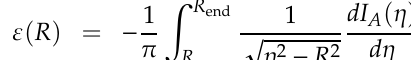
Figure 4. Population coefficients for 𝑝 = 6. The green, red, and blue lines represent 𝑟 (cid:2868)(cid:2874) , 𝑟 (cid:2869)(cid:2874) , and 𝑟 (cid:2870)(cid:2874) , respectively. The solid, dashed, and dash-dotted lines represent those at 𝑛 (cid:2915) = 10 16 , 10 17 , and 10 18 m − 3 , respectively.